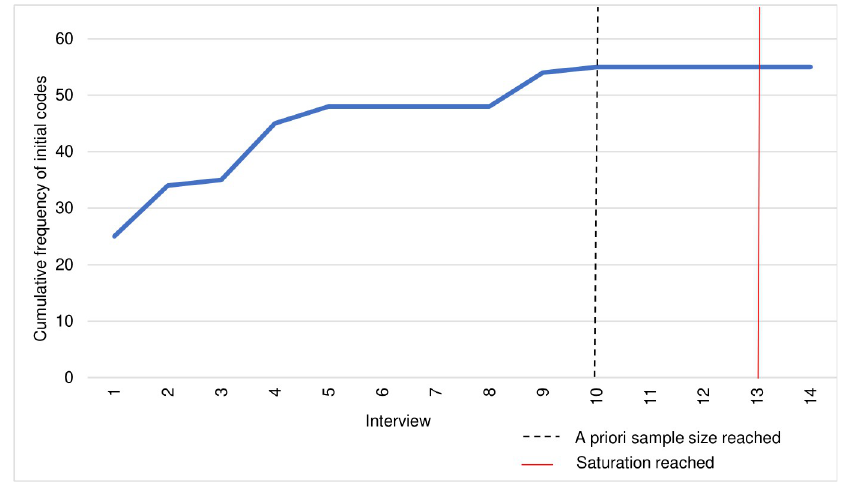
Fig 1. Cumulative frequency of initial codes.